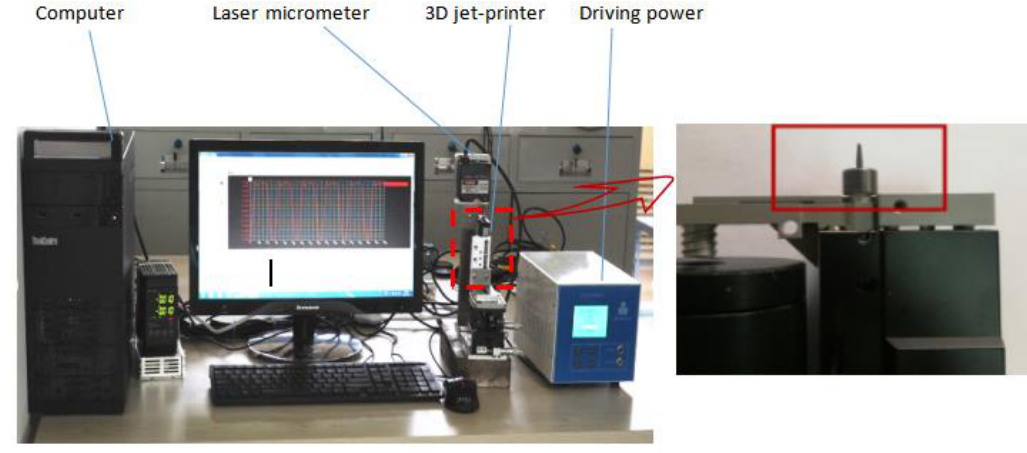
Figure 10. Test bench for needle movement.